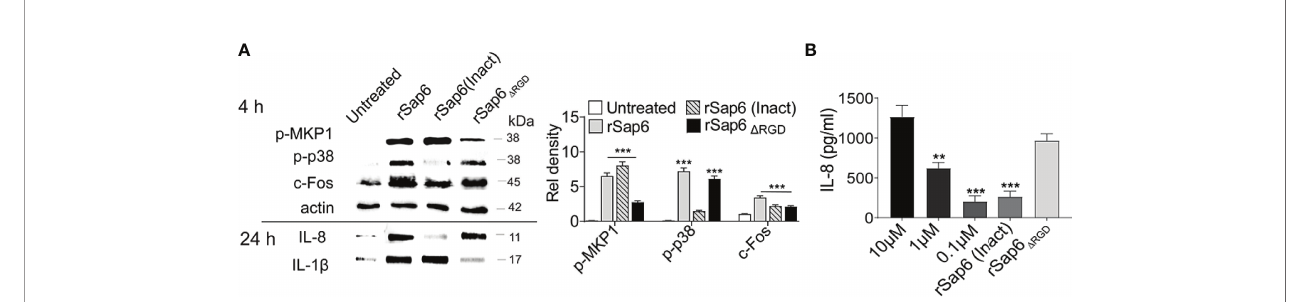
FIGURE 3 | Both Sap6 protease activity and its RGD motif modulate MAPK signaling and cytokine release. OECs were treated with rSap6, heat inactivated rSap6 (Inact) and rSap6 D RGD for 3 h (for cell lysates) or 24 h (for culture supernatants). (A) OEC cell lysates treated with rSap6 (Inact) failed to induce p38 phosphorylation and IL-8 release without affecting MKP1 phosphorylation, c-Fos expression or IL-1 b compared to active rSap6. OECs treated with rSap6 D RGD showed reduced MKP1 phosphorylation and IL-1 b release without affecting p38 phosphorylation, c-Fos and IL-8 levels. (B) OEC culture supernatant was collected after 24 h of treatment with rSap6 (0.1-10µM), rSap6 (Inact, 10µM) or rSap6 D RGD (10µM) and IL-8 was quantitated by ELISA. IL-8 secretion was dose dependent with rSap6 (0.1-10µM) and was signi fi cantly (P<0.001) reduced by treatment with rSap6 (Inact) compared with active rSap6 or rSap6 D RGD . Data are mean ± SEM and are representative of three independent experiments. Signi fi cance was calculated using two-way ANOVA compared to untreated OECs. P values are, p ≤ 0.01 (**), p ≤ 0.001